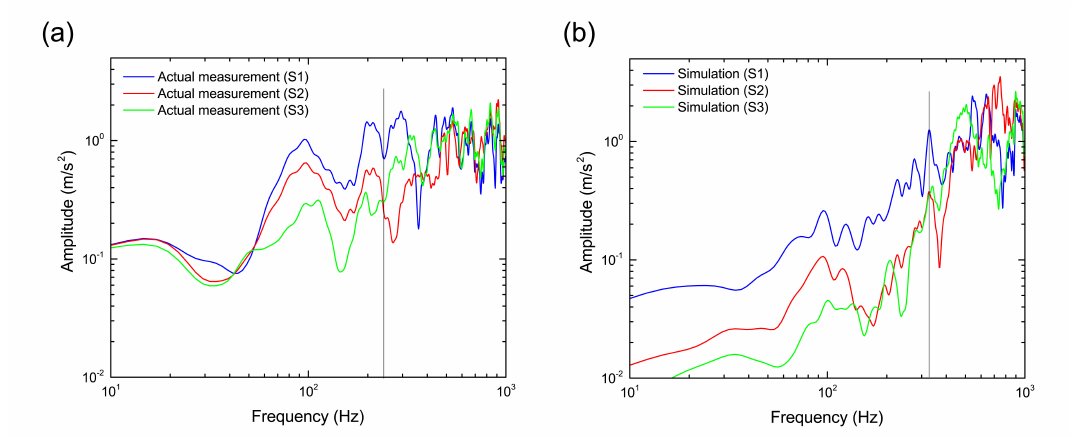
Figure 10. Comparison of frequencies of sleeper vertical acceleration at different sensor positions in ( a ) actual measurement and ( b ) numerical simulation. The linear spectra are smoothed by applying a Parzen window with a bandwidth of 20